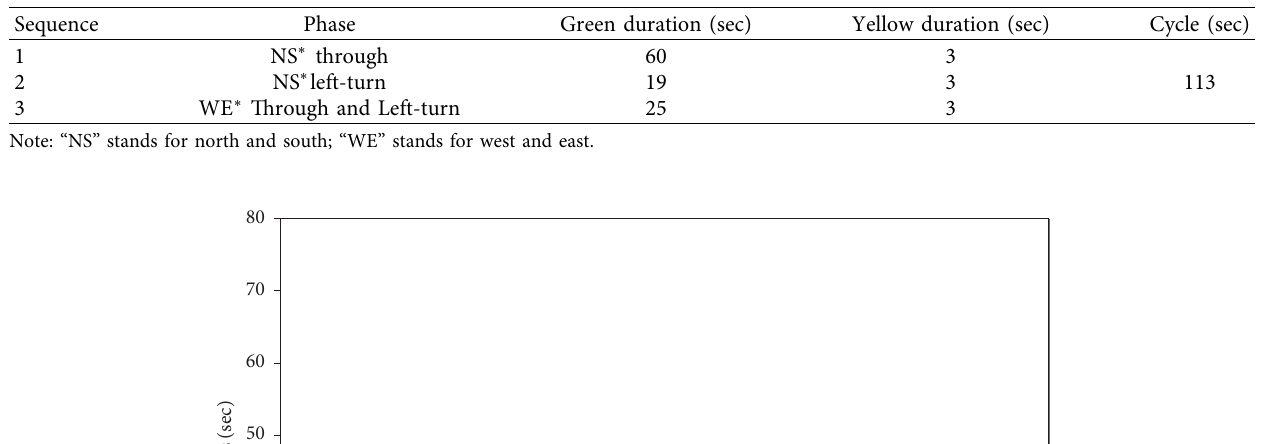
Table 3: Te background timing plans.